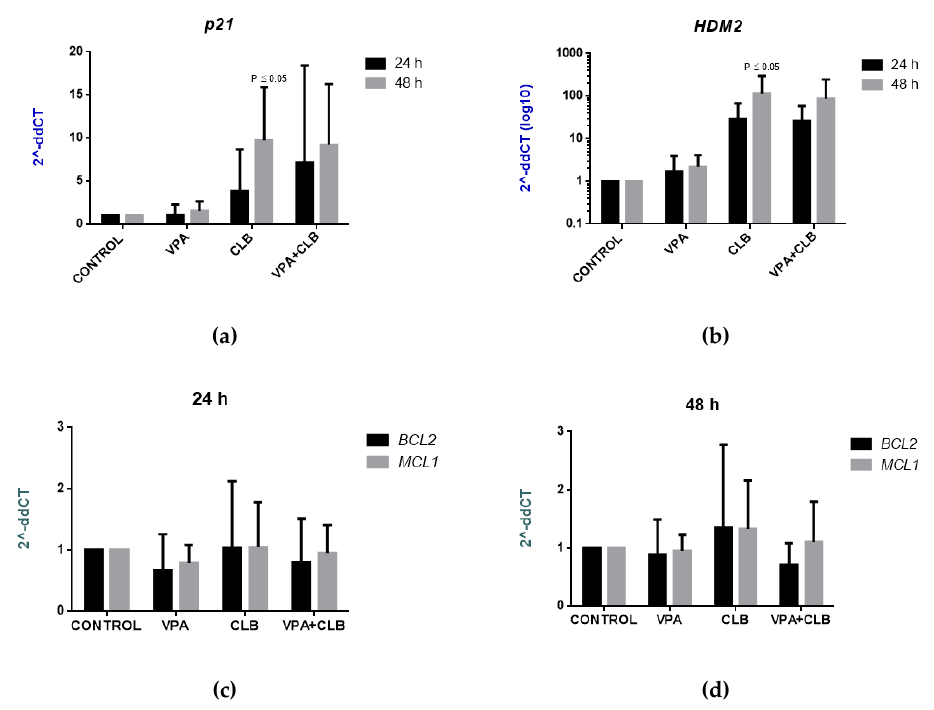
Figure 4. Effects of CLB and VPA on expression of apoptosis-related genes ( n = 11). Graphs show differences in TP53 expression genes: ( a ) p21 and ( b ) HDM2 , and Bcl-2 family genes BCL2 and MCL1 : ( c ) after 24 h of incubation and ( d ) after 48 h of incubation. P values show significant differences versus control groups.